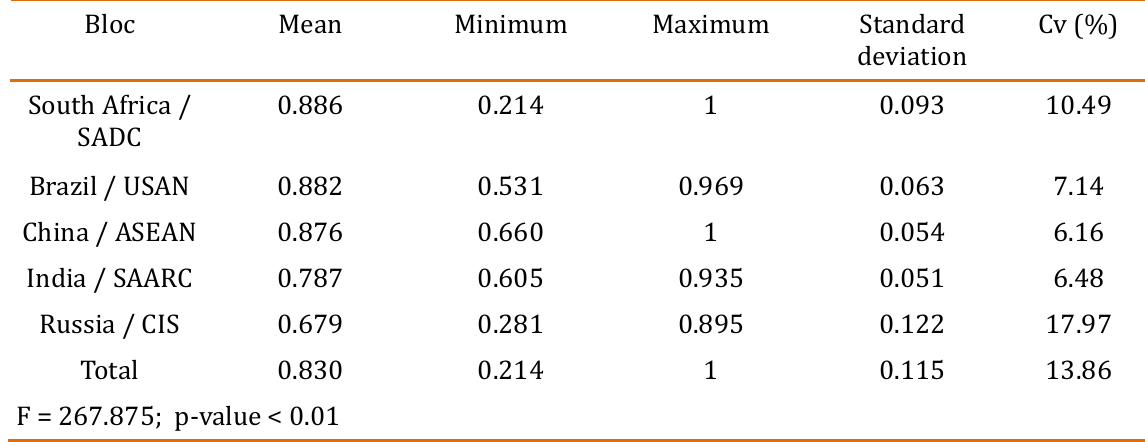
Table 01. Descriptive statistics of the affinity between BRICS leader and region Bloc Mean Minimum Maximum Standard South Africa / 0.886 SADC